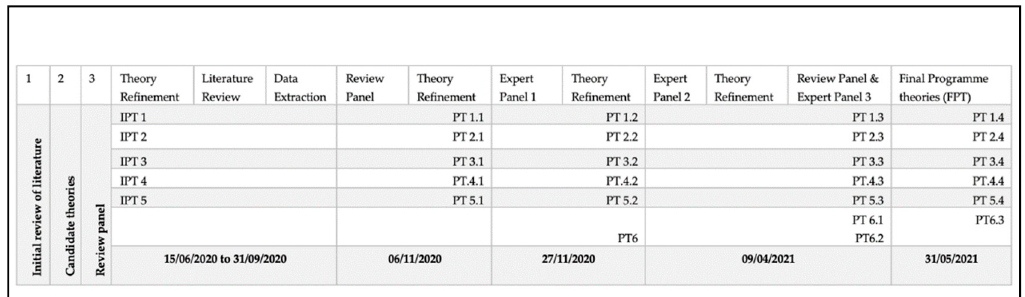
Figure 3. Iterative development of program theory.